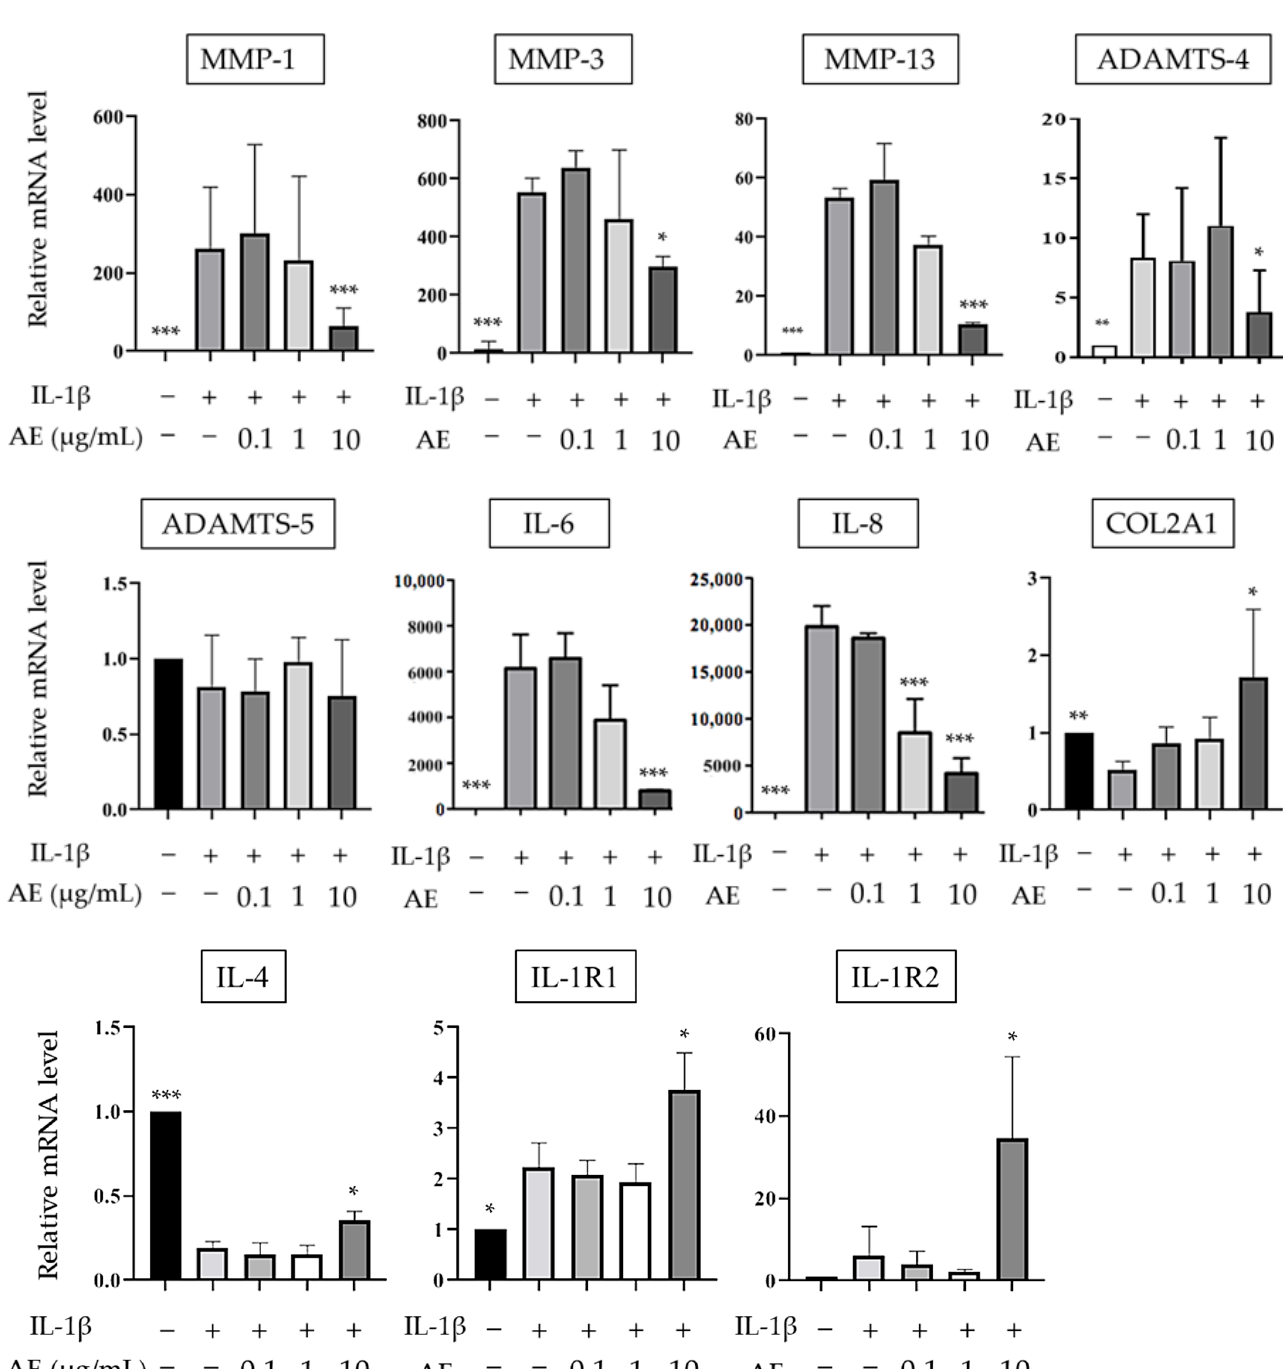
Figure 1. The effect of AE on IL-1 β -stimulated mRNA expressions of anabolic and catabolic factors by NHCs. The results are expressed as the relative expression levels (mean ± SD) to control samples without IL-1 β stimulation or AE treatment. Statistical significance: Tukey’s multiple comparisons test * p < 0.05, ** p < 0.01, *** p < 0.001 compared to IL-1 β stimulation without AE.